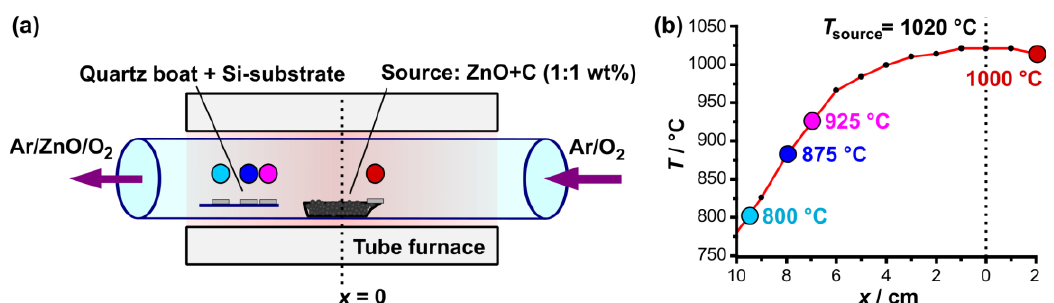
Figure 1. Schematic representation of the tube furnace system ( a ) and the corresponding temperature profile during the ZnO growth ( b ). The sample positions are mapped to their respective process temperatures by the colored indicators. The source is located at x = 0 cm and consists of a 1:1 mixture (weight) of ZnO and graphite